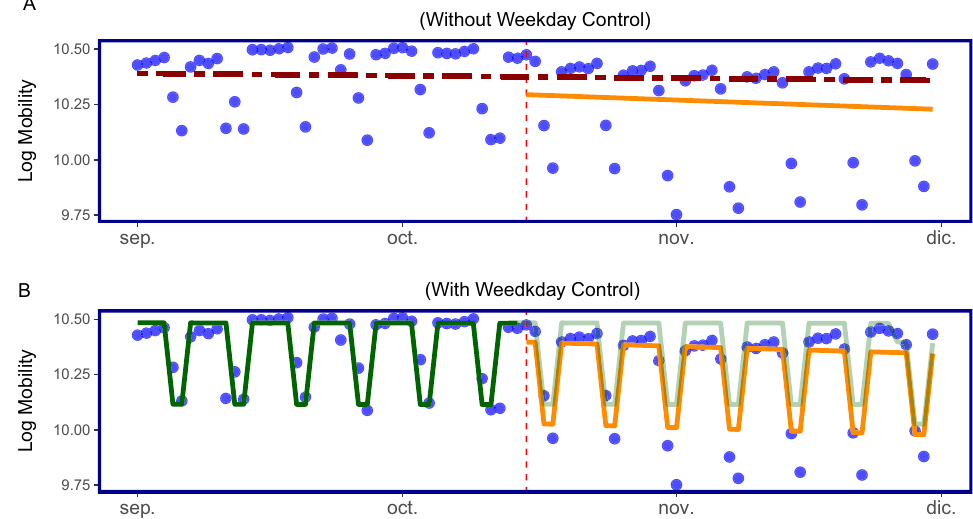
Figure 5. Linear regression model for total daily mobility in Cataluña: panel ( A ) shows the fitted values from the regression without a weekday control whereas panel ( B ) shows the fitted values with a weekday control. The vertical dotted line in both panels indicates the date on which the policy was introduced. The red dotted line in panel ( A ), before the introduction of the policy, shows the fitted values of the regression line from the observed data. The same red dotted line after the introduction of the policy shows the regression line had the policy not been implemented (using the fitted values from before the policy). The orange line shows the fitted values of the regression based on the observed data after the policy was introduced. The difference can be seen as the reduction in mobility. Panel ( B ) also shows the fitted values before and after the policy. The darker green line represents the fitted values before the policy and the transparent green line after the policy represents the fitted values had the policy not been introduced. The orange line represents the fitted values on the data points after the policy was introduced and the difference can be seen as the reduction in mobility due to the policy. In both panels, the blue points represent the observed values of the mobility levels on a daily basis. That is, the data started on Tuesday, September 1st 2020 and thus the first four points correspond to mobility levels from Tuesday 1st to Friday 4th. We then see two points significantly drop off on the weekend. The following week, we observe three significantly lower points. One of the data-points being Friday 11th September, also shown in Fig. 4 previously (2020-09-11, Fiesta Nacional de Cataluña) and the other two being the weekend reduction in mobility. On the x-axis, dic refers to Diciembre